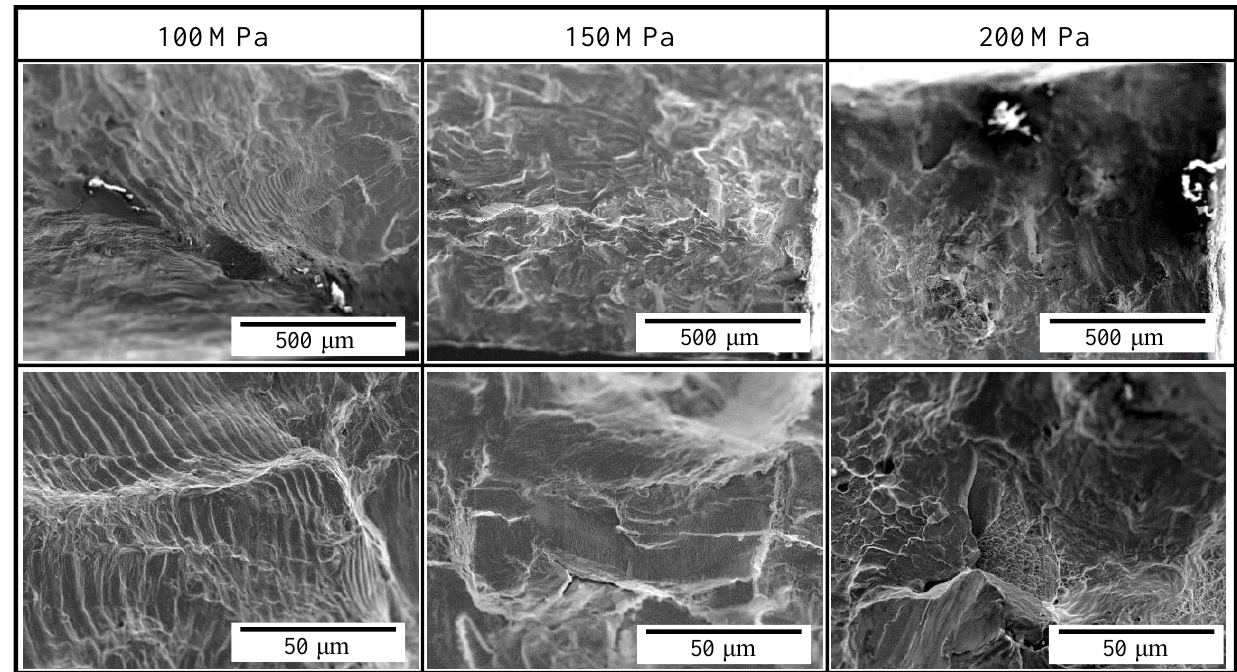
Figure 6. Secondary electron images of fracture surfaces of untreated specimens after the low cycle fatigue test. Bottom images are magnified images of upper ones.